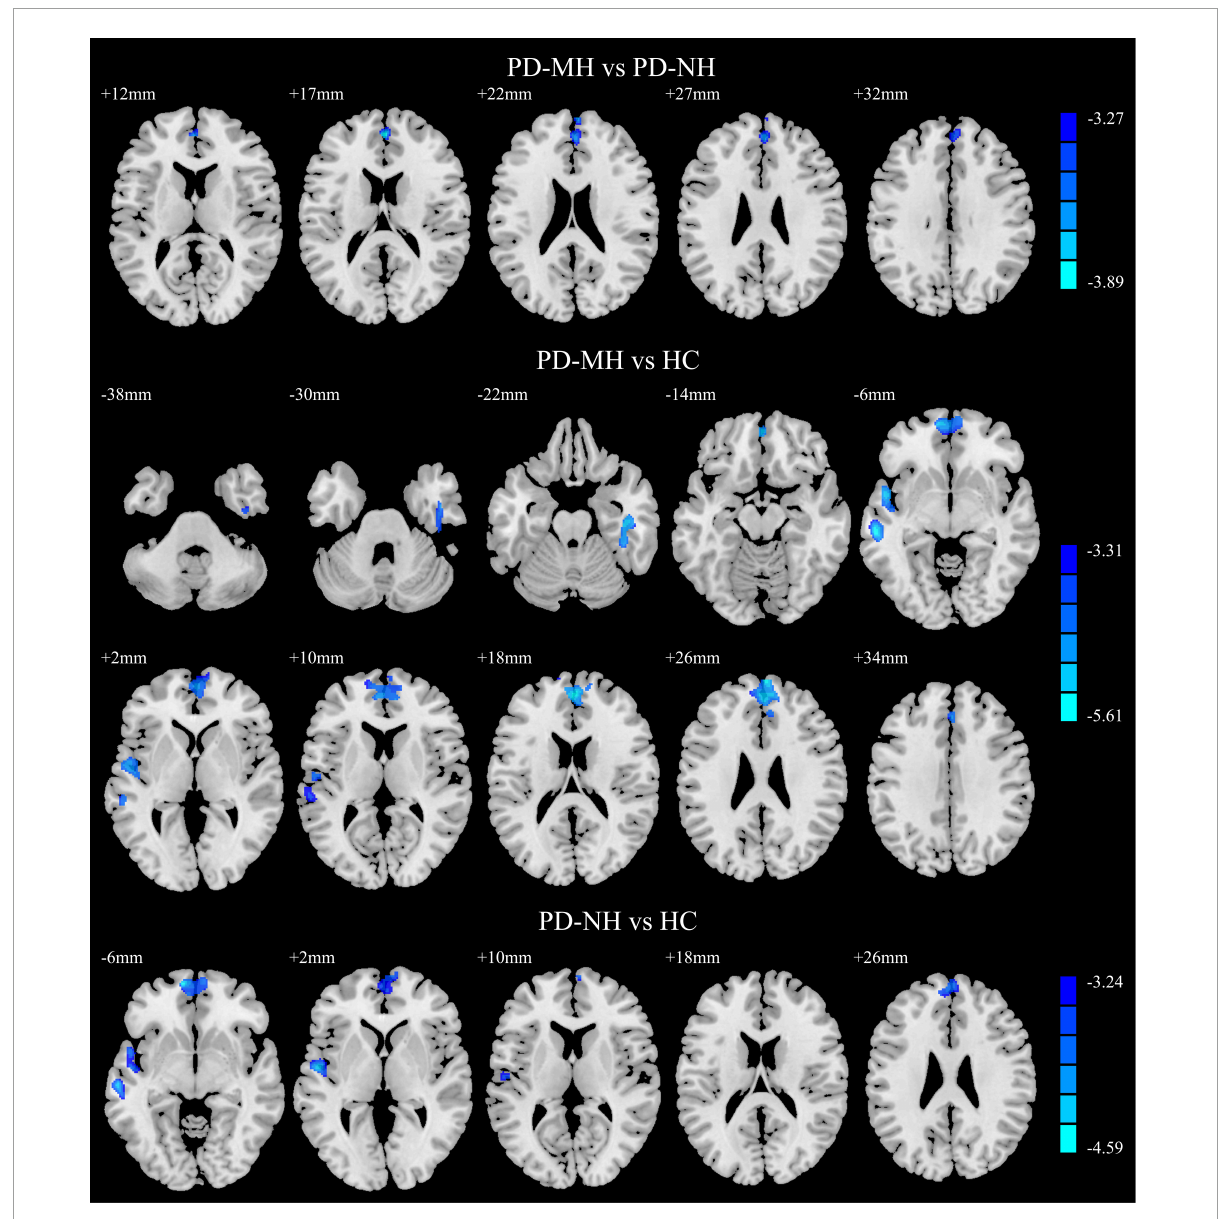
FIGURE2 Significant differences of gray matter volume between the groups. Blue and green indicated the reduced gray matter volume. Using GRF correction, voxel level P < 0.001 and cluster level P < 0.05 were considered statistically significant difference. PD, Parkinson’s disease; MH, minor hallucination; NH, no hallucinations (and delusions); HC, healthy control; GRF, Gaussian random